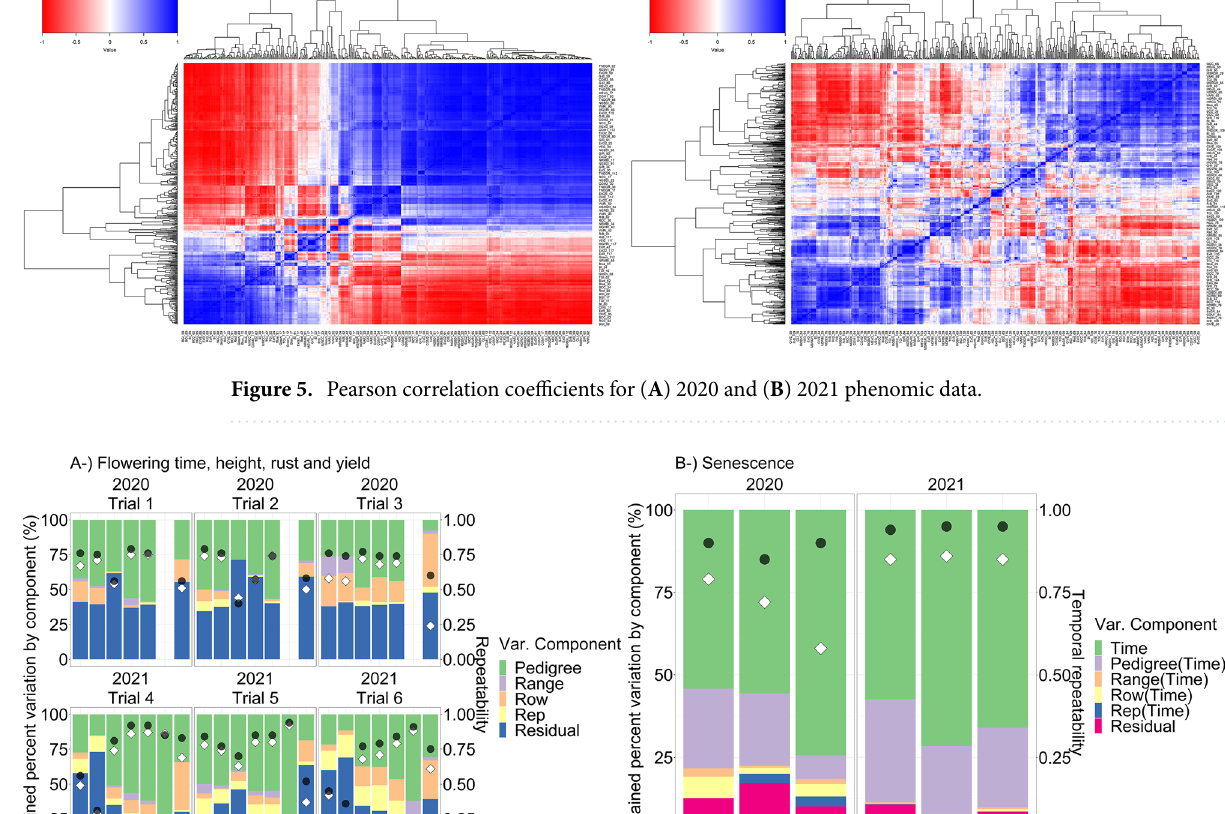
senescence scored on 16 July 2021 (109 DAP), 23 July 2021 (116 DAP), 27 July 2021 (120 DAP), and 29 July 2021 (122 DAP) (Fig. 8). In addition, support vector machine regression with radial kernel had the highest predic- tion accuracies (~ 0.80 and ~ 0.75 respectively) for senescence on 27 July 2021 (120 DAP) and 29 July 2021 (122 DAP) (Fig. 8). For rust measurements taken in 2021, random forest regression performed best with a prediction accuracy of ~ 0.72, followed by elastic net and lasso regressions with prediction accuracies of ~ 0.70 (Fig. 9). The general linear model was outperformed by all eight machine learning regressions in each case. Mean phenomic prediction accuracies across all predicted traits for each model are provided in Supplementary Data 3. The linear model displayed the highest RMSE values for all predicted traits, ranging between 65.8 and 2396.5. In contrast, all machine learning regressions across all predicted traits ranged between 0.328 to 17.0 (Supplementary Figs. 1 and 2; averages of all RMSE values from each predicted trait and model’s 500 bootstraps are in Supplementary Data 2). Variation in prediction accuracies among machine learning models is a primarily a product of each model’s tolerance for nonlinearity, outliers, and collinearity, amount of training data required, and whether the model is parametric or nonparametric. The usefulness of each model is dependent on the structure of the dataset to which it is applied. Variable importance scores. Variable importance scores ( varImp ) were generated by the lasso algorithm. Lasso was selected due to its tolerance for many predictors that exert minimal influence on the target variable. Figure 10 reveals important time (in DAP) and VI combinations that uncover early time indicator(s) of rust and days to senescence and before rust and senescence physiologically appear. RCC was nominated (based on varImp scores) as one of the critical vegetation indices for rust and days to senescence; its phenotypic values